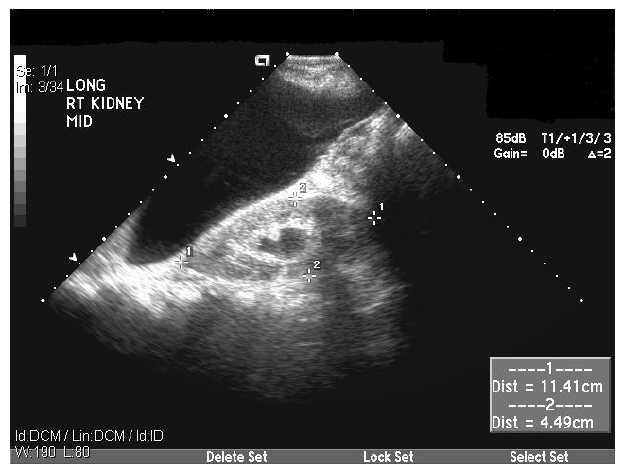
FIGURE 1 . USG abdomen shows right kidney with hydronephrosis.